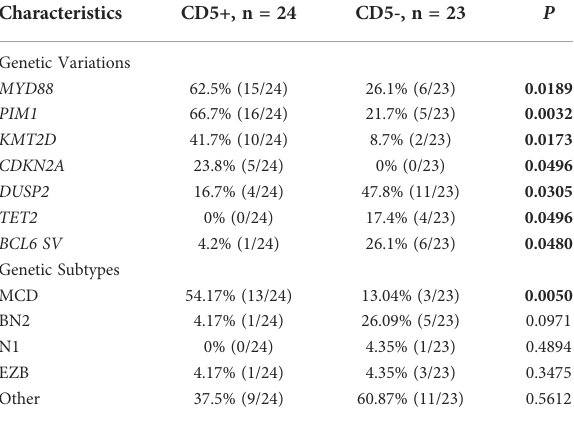
TABLE 2 Genetic variations and subtyping of CD5+/CD5- DLBCL.